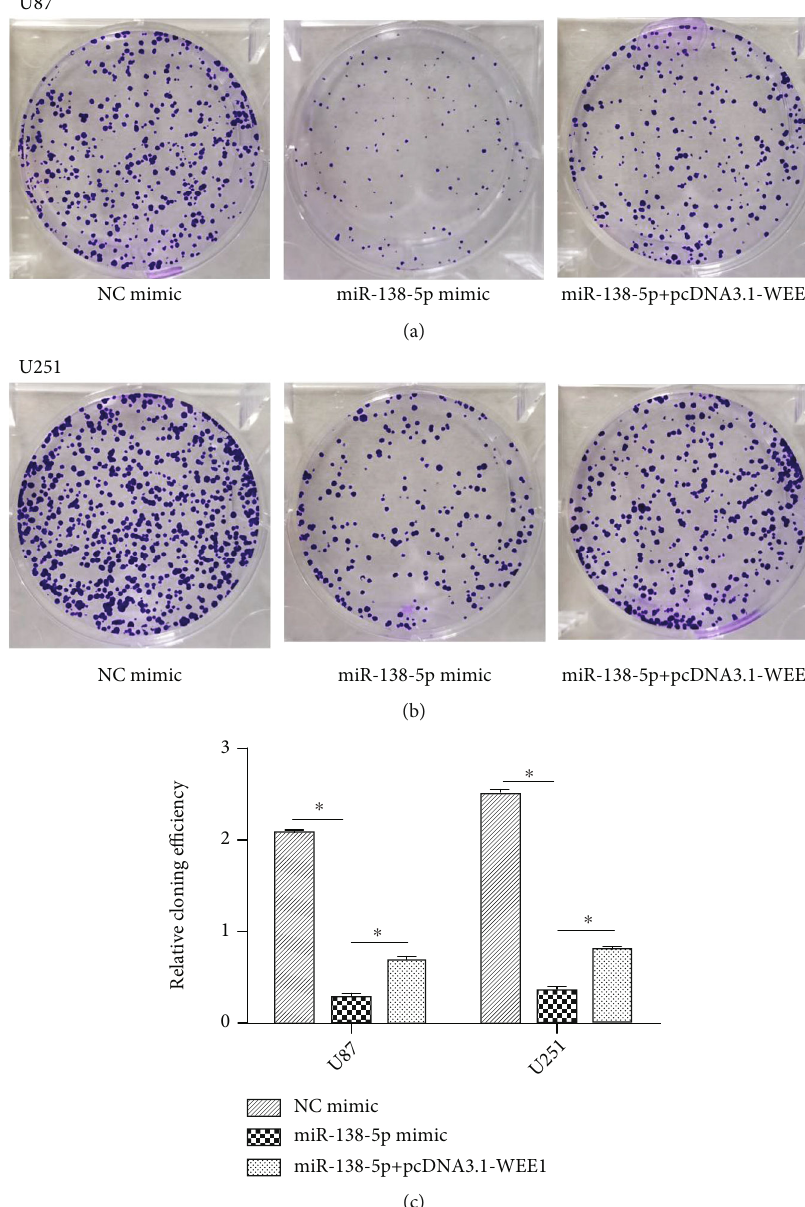
Figure 7: The expression of WEE1 inhibited miR-138-5p on proliferation of glioma cells. (a, b) Comparison of U87 and U251 cell colonies two weeks after transfection of NC mimic, miR-138-5p mimic, and miR-138-5P+pcDNA3.1-WEE1. (c) The reintroduction of WEE1 signi fi cantly increased the number of colonies in U87 and U251 cells compared with the miR-138-5P mimic alone transfection group. Each experiment was repeated at least three times. ∗ P < 0 : 05